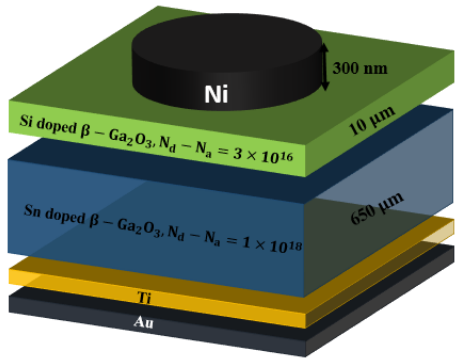
Figure 1 . A schematic of the structure of the Ni/β-Ga 2 O 3 SBD studied in this work. Figure 1. A schematic of the structure of the Ni/ β -Ga 2 O 3 SBD studied in this